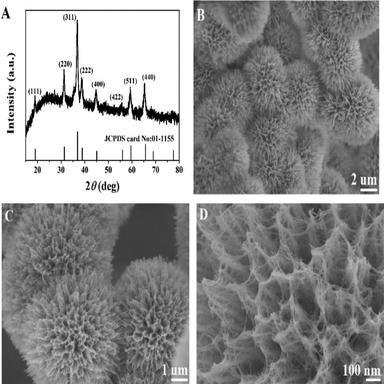
(A) XRD pattern and (B–D) SEM images of CuCo2O4 dandelion.